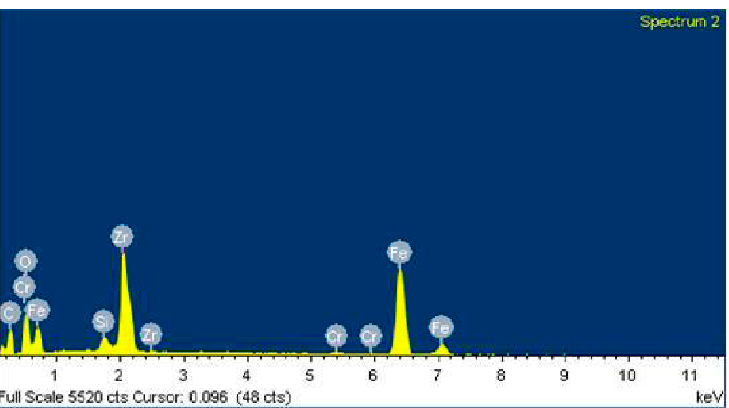
Figure 21. EDS spectrum of the marked area in Figure 19, where traces of ZrO 2 appear.